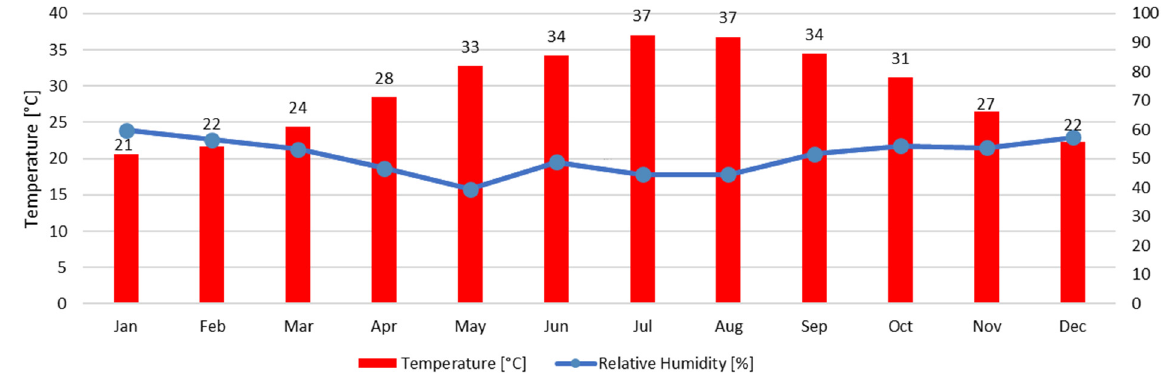
Figure 10. Dubai t and r.h. during the average year.